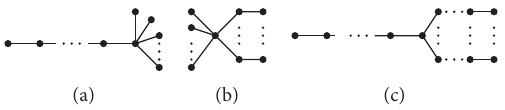
Figure 1: The elements of the class PT